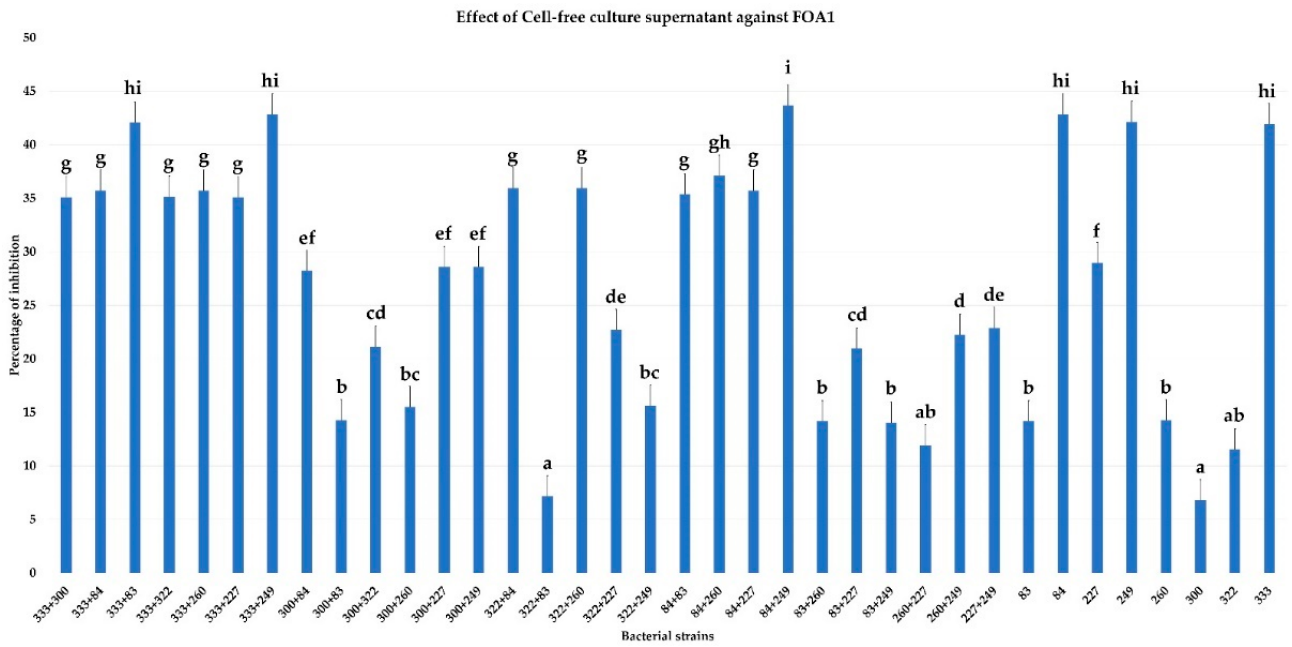
Figure 6. Percentage of inhibition of combined bacterial strains against FOA1. Data shown are the means ± the standard error. Different letters between bars in each group indicate a significant difference at ( p < 0.05) determined by ANOVA with the comparison of means using Tukey’s HSD.